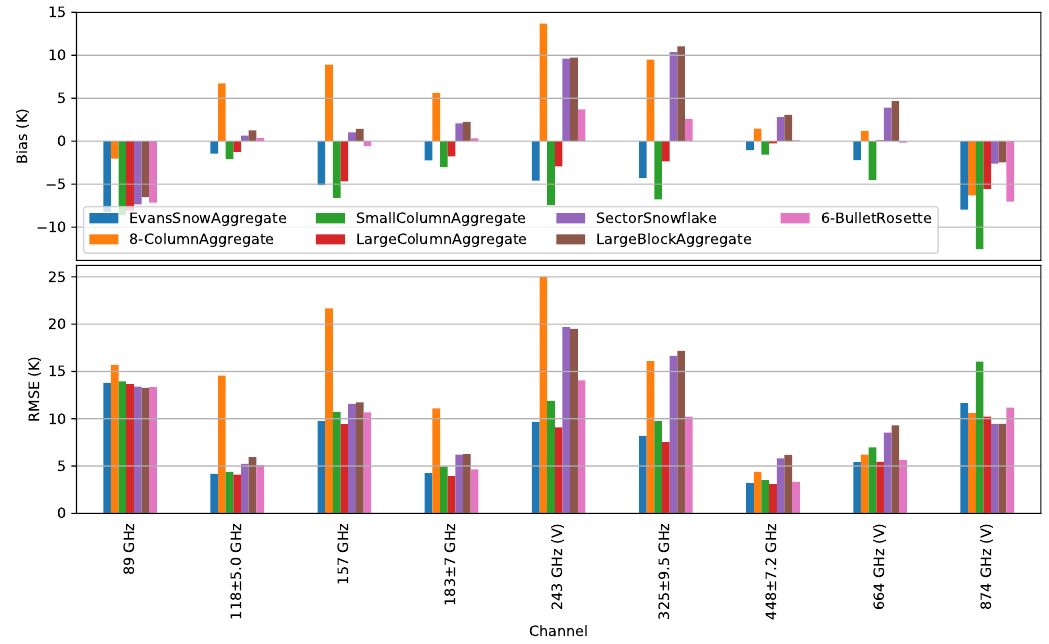
Figure 7. Bias ( top ) and RMSE ( bottom ) of first-guess departures (observed-simulated) using different ice particle habits for selected channels. Results for all channels can be found in Figure S10 in the